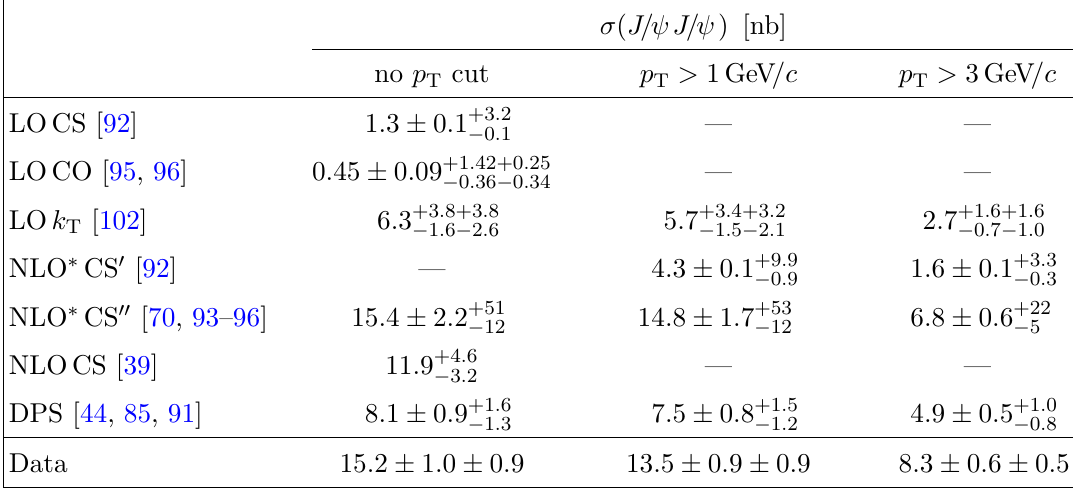
NNPDF 3.0 NLO PDFs with (cid:11)